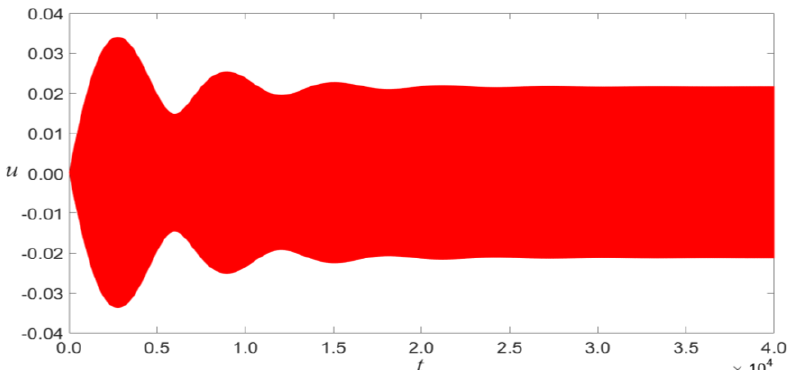
Figure 4. Time evolution of the midpoint displacement of microbeam under the context of primary resonance for V DC = 1.5 V, V AC = 0.08 V, and σ =